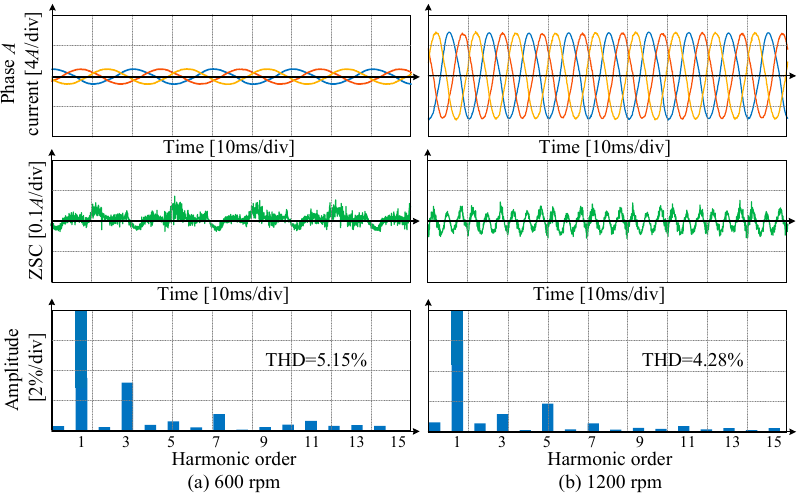
Figure 25. ( b ) 1200 rpm situation.